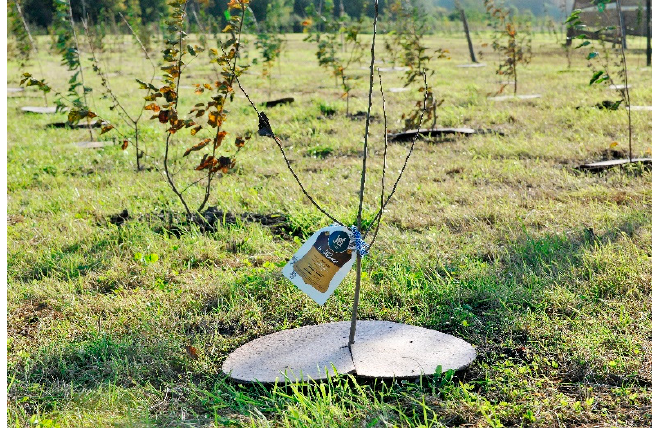
Figure 10. Birth forest Gentbrugse Meersen Ghent Belgium: celebration of the birth of a new-born babies with the planting of young trees (photograph by Patrick Henry, © Stad Gent).